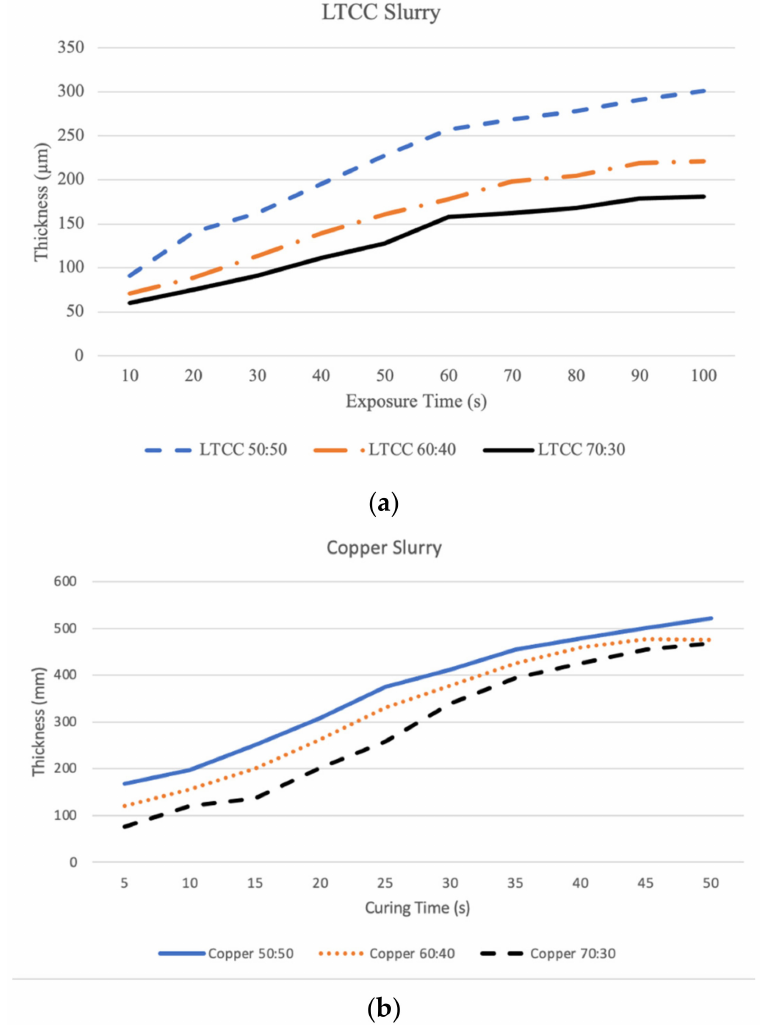
Figure 5. Cured layer thickness for different weight ratios and different exposure times: ( a ) LTCC and ( b ) copper